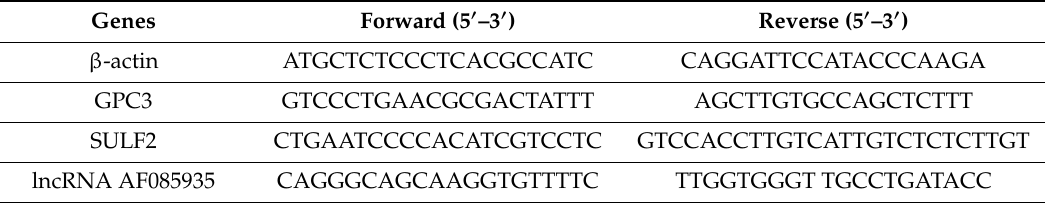
Table 2. Primers sequence of the studied